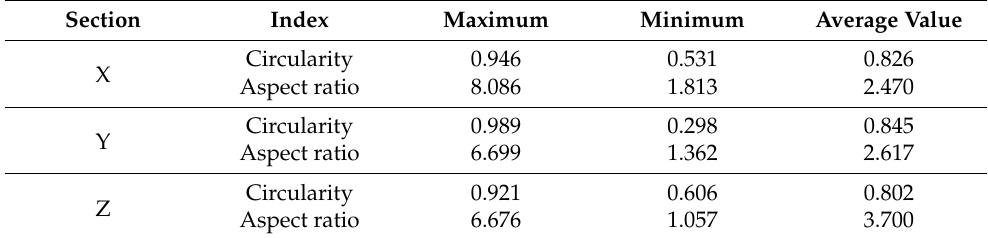
Table 2. Particle shape statistics of glacial till samples.